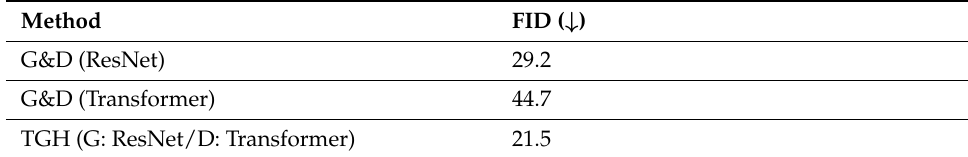
Table 3. Comparison of FID of Different GAN.